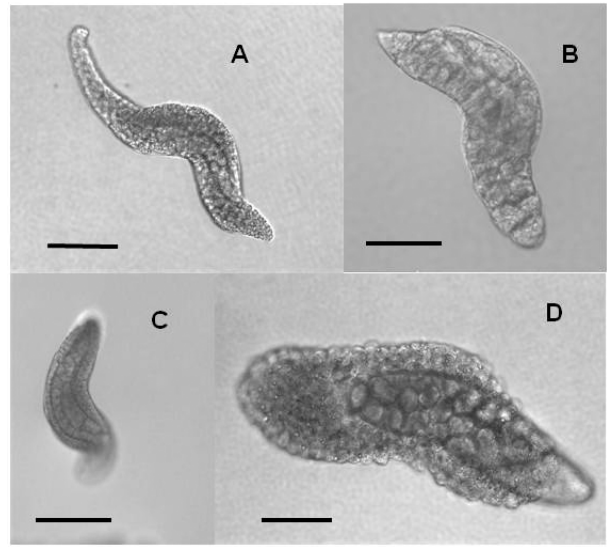
Fig. 4. Different morphotypes of Blastodinium spp. showing a more or less pronounced spirally twisted shape. (A) : BOUM8, (B) : BOUM37, (C) : BOUM50, (D) : BOUM7. Scale